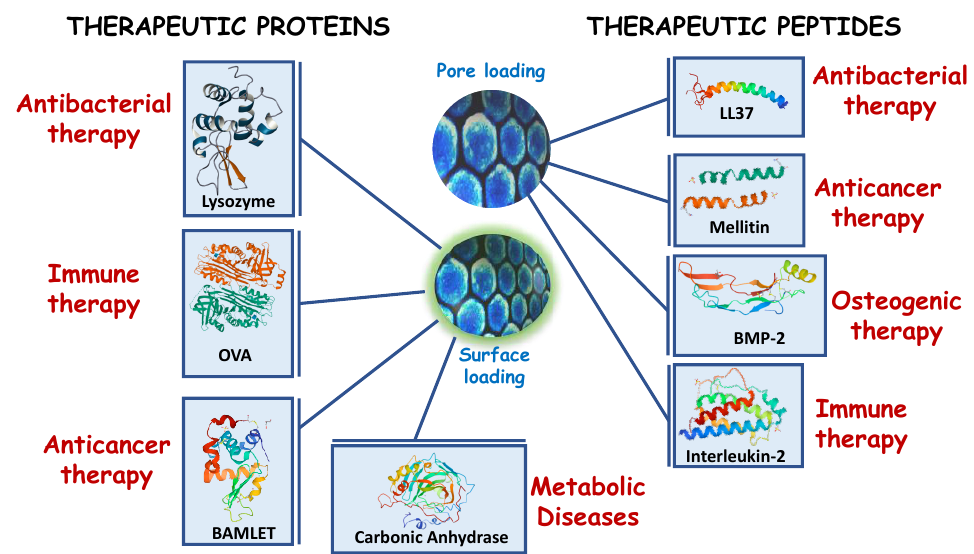
Figure 3. Delivery of proteins and peptides with mesoporous silica nanoparticles makes it possible to create nanotherapeutics for a wide range of diseases .